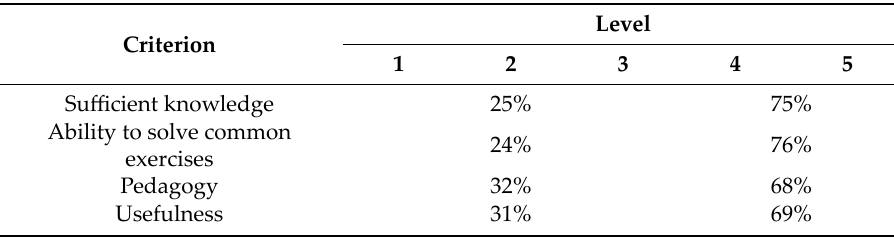
Table 5. Results of the survey.